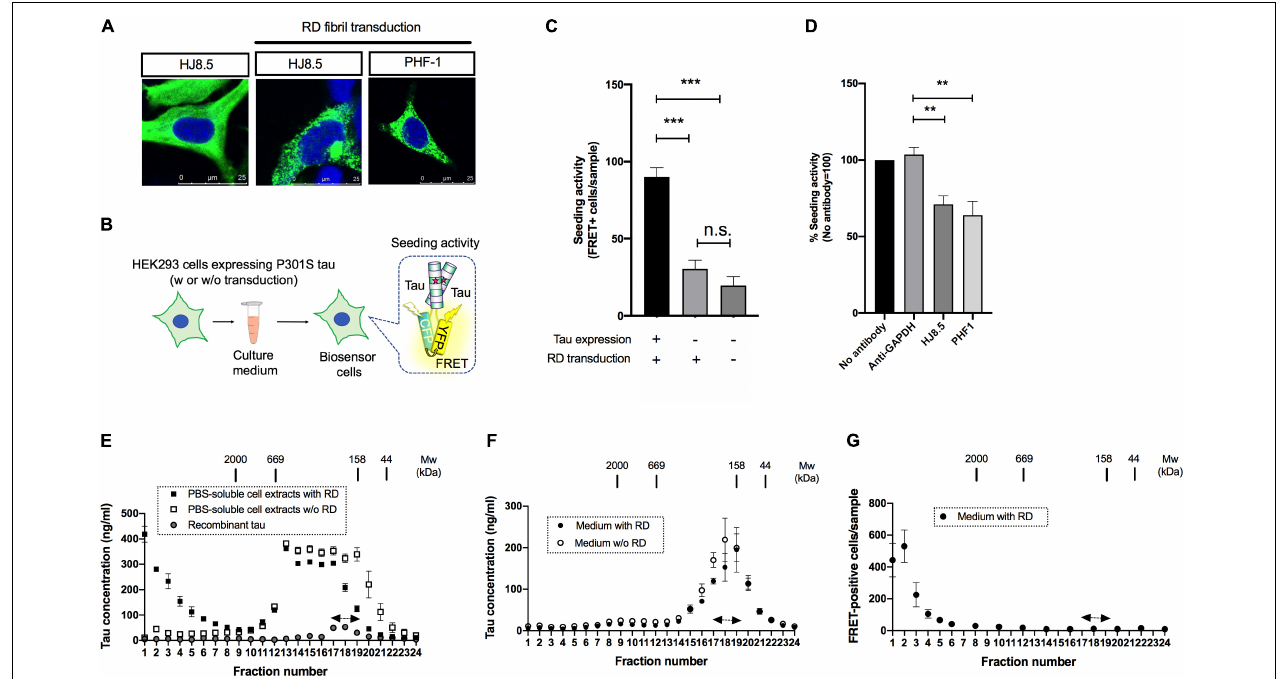
FIGURE 1 | Seed-competent tau released from cells is enriched in the fractions of ∼ 2,000kDa. (A) HEK293 cells expressing full-length tau with P301S mutation were immunostained with HJ8.5 antibody or PHF-1 antibody (green) after transduction of RD fibrils. Nuclei were stained by DRAQ5 (blue). (B) Schematic depiction of tau propagation assay used in the study. (C) The addition of media from P301S full-length tau expressing HEK293 cells transduced with RD fibrils significantly increased FRET-positive biosensor cells compared to the cells without tau expression or the cells without tau expression and RD transduction. N = 3, ∗∗∗ p < 0.001. (D) The media from full-length tau expressing cells with RD transduction were incubated by indicated antibodies. Seeding activities in immunodepleted media were analyzed by tau biosensor cells. N = 4. ∗∗ p < 0.01. (E) The PBS-soluble cell extracts from HEK293 cells expressing full-length tau with or without RD transduction were separated using a size-exclusion chromatography. N = 3. Eluted fractions were analyzed with Tau-5/HJ8.7 ELISA. Recombinant 2N4R tau was loaded as a control. Monomer fractions predicted by recombinant tau were indicated by arrows. (F) The media from full-length tau expressing cells with or without RD transduction were separated using a size-exclusion chromatography. Eluted fractions were analyzed with Tau-5/HJ8.7 ELISA. N = 4. (G) The media from full-length tau expressing cells with RD transduction were separated by a size-exclusion chromatography and analyzed with tau biosensor cells. N =